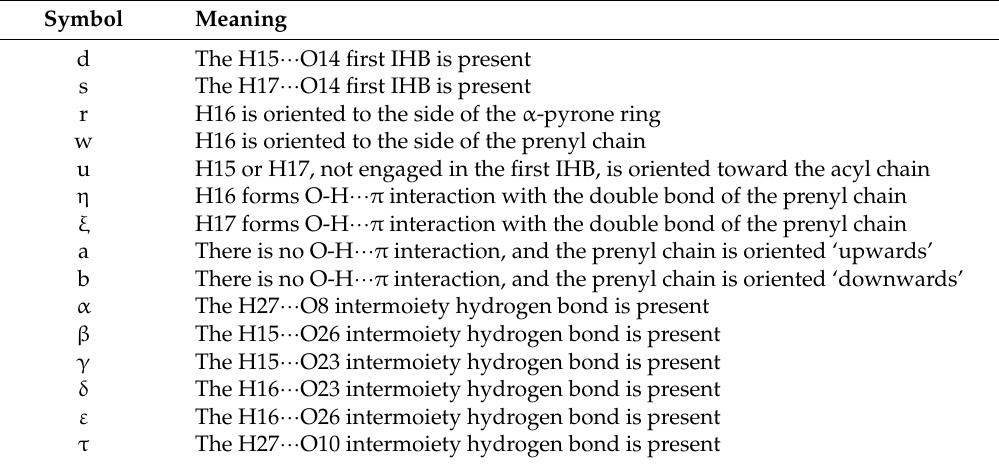
Table 1. Symbols utilised to specify geometrical characteristics in the acronyms denoting the conformers. The symbols d, s, r, w, u, η and ξ have the same meanings as in other studies on ACPLs